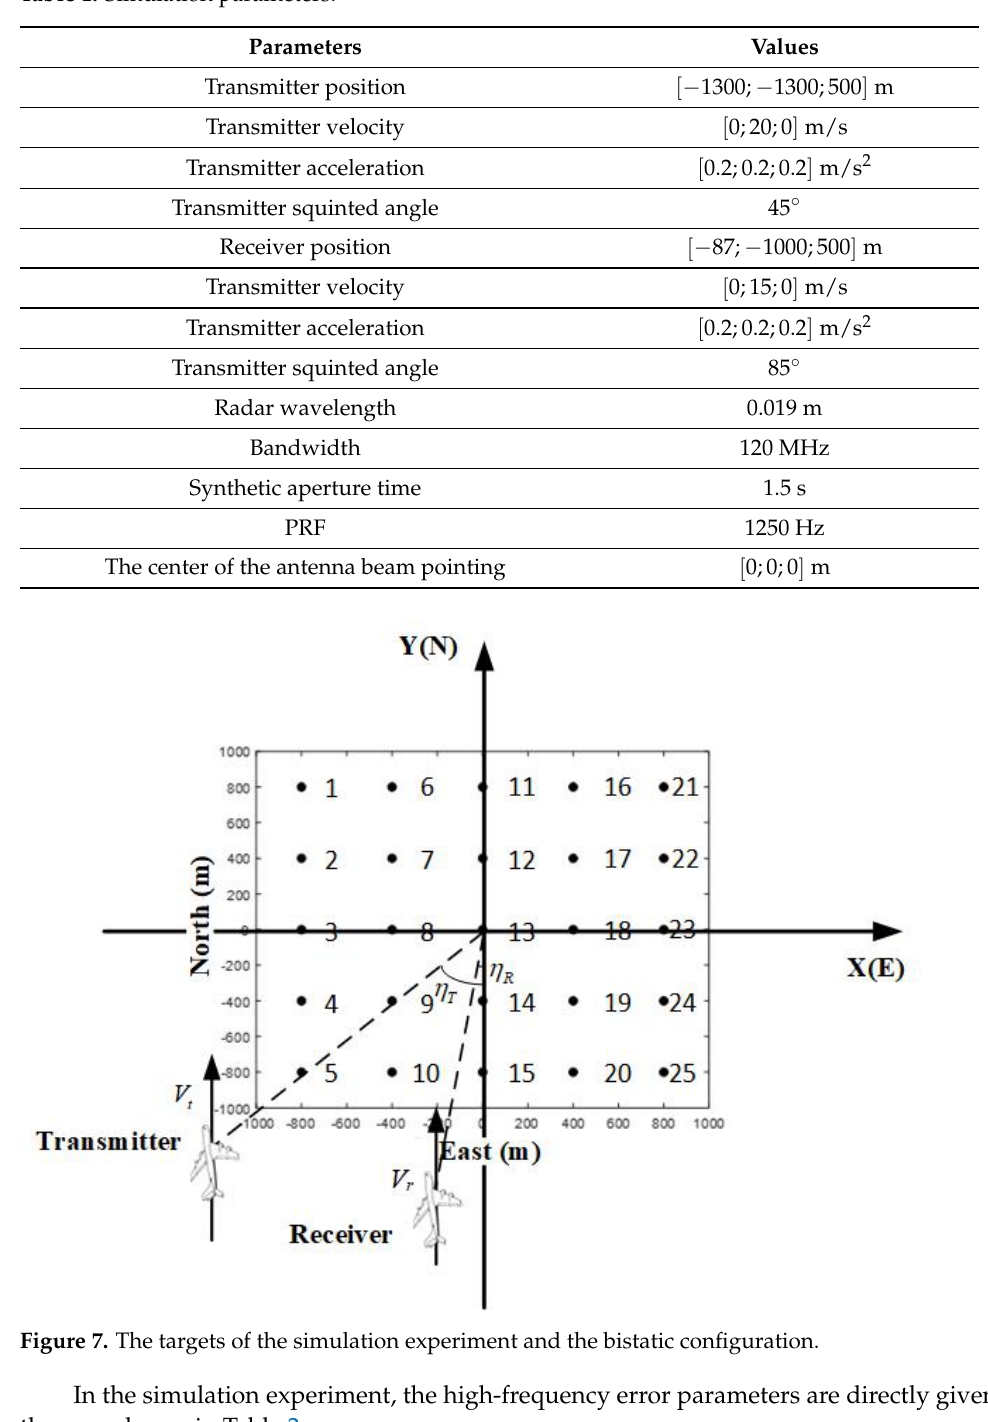
Table 1. Simulation parameters.